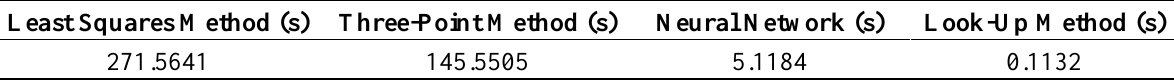
Table 2. Durations of solving process with regard to different